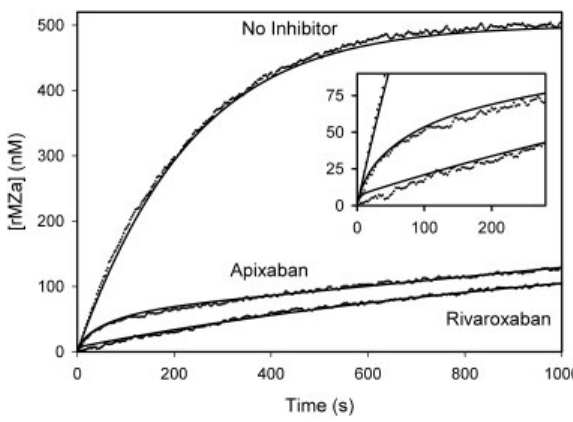
Fig. 7 rMZ was used instead of prothrombin to monitor activation cleavage at Arg320 by prothrombinase using DAPA in the absence or presence of apixaban or rivaroxaban (30 nM). rMZa generation was monitored at 2-s intervals in a fl uorescent plate reader at 37°C. Data were fi t to a mixed inhibition model